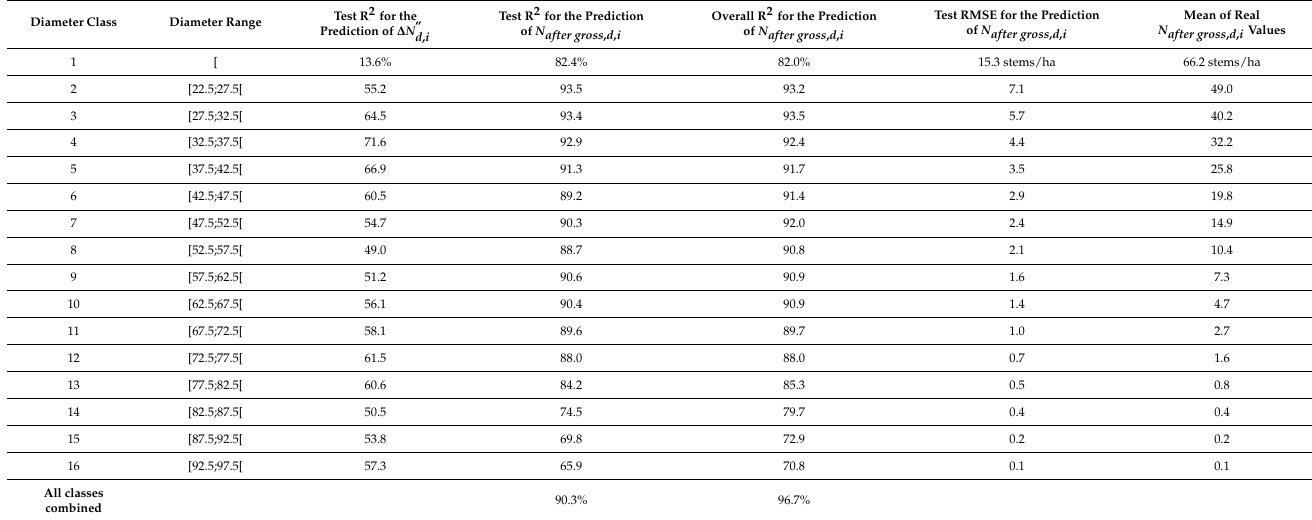
Table 2. Performances of the models measured by R 2 and RMSE scores for respective prediction of ∆ N (cid:48)(cid:48) and N after gross , d , i (the overall R 2 is measured on the whole data set when the models are d , i trained on the whole data